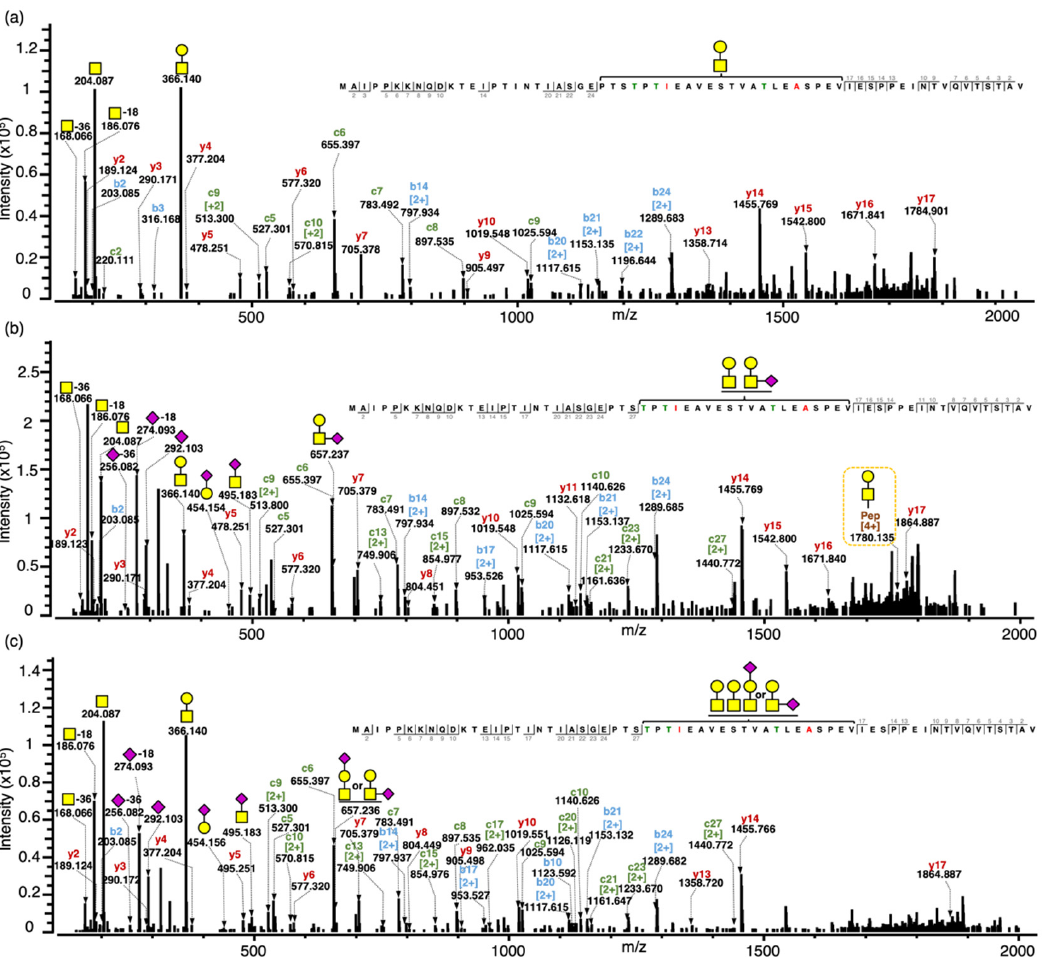
Figure 2. Annotated tandem MS spectra for intact gCMP with sequence B containing one, two and three O -glycans. ( a ). Tandem MS spectrum for the intact gCMP with sequence B containing one O -glycan (GalNAcGal) and one phosphate, observed m / z 1424.304 [M+5H] 5+ , scan time = 21.96 min found in the CMP powder 1 sample. ( b ). Tandem MS spectra for the intact gCMP with sequence B containing two O -glycans (GalNAcGal and GalNAcGalNeuAc) and one phosphate, observed m / z 1555.544 [M+5H] 5+ , scan time = 21.84 min found in the CMP standard sample. ( c ). Tandem MS spectra for the intact gCMP with sequence B containing three O -glycans (GalNAcGal, GalNAcGal and GalNAcGalNeuAc) and one phosphate, observed m / z 1628.582 [M+5H] 5+ , scan time = 21.25 min found in the CMP powder 2 sample. Glycan symbols: yellow square, N -acetyl galactosamine; yellow circle, galactose; and purple diamond, N -acetyl neuraminic acid.